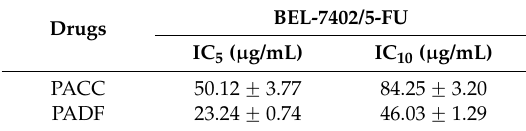
Table 2. IC 5 and IC 10 of PACC and PADF on BEL-7402/5-FU cell ( x ˘ s, n = 6).